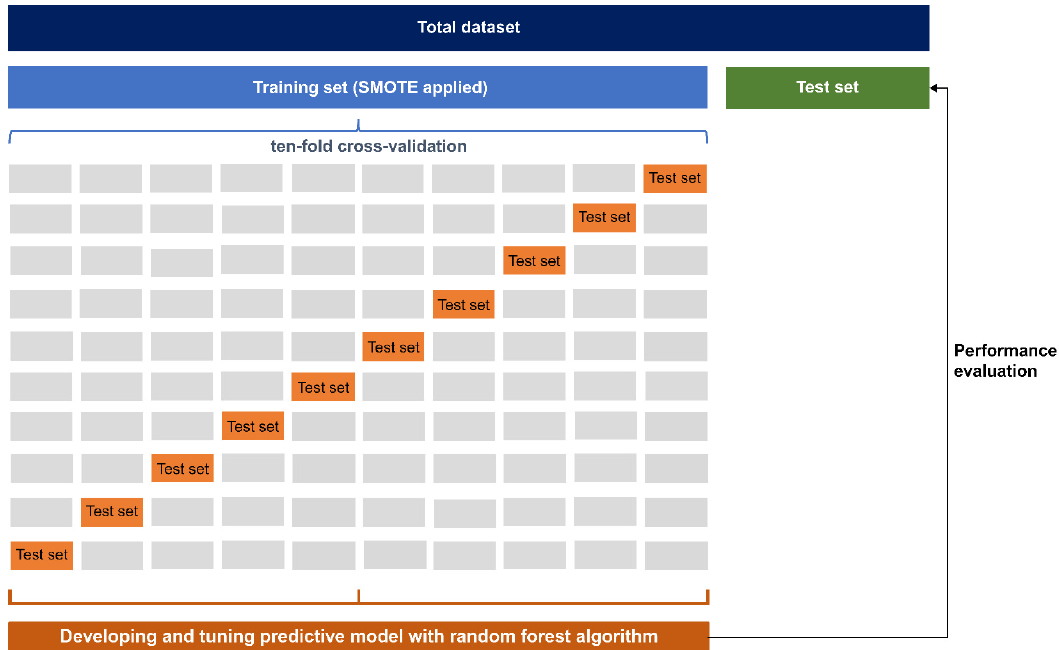
Figure 1. The overview of machine learning .